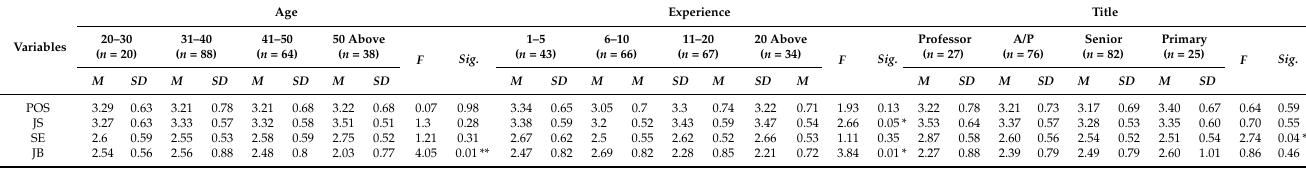
Table 3. Significant differences in perceived organizational support, job satisfaction, self-efficacy, and job burnout in age, experience, and